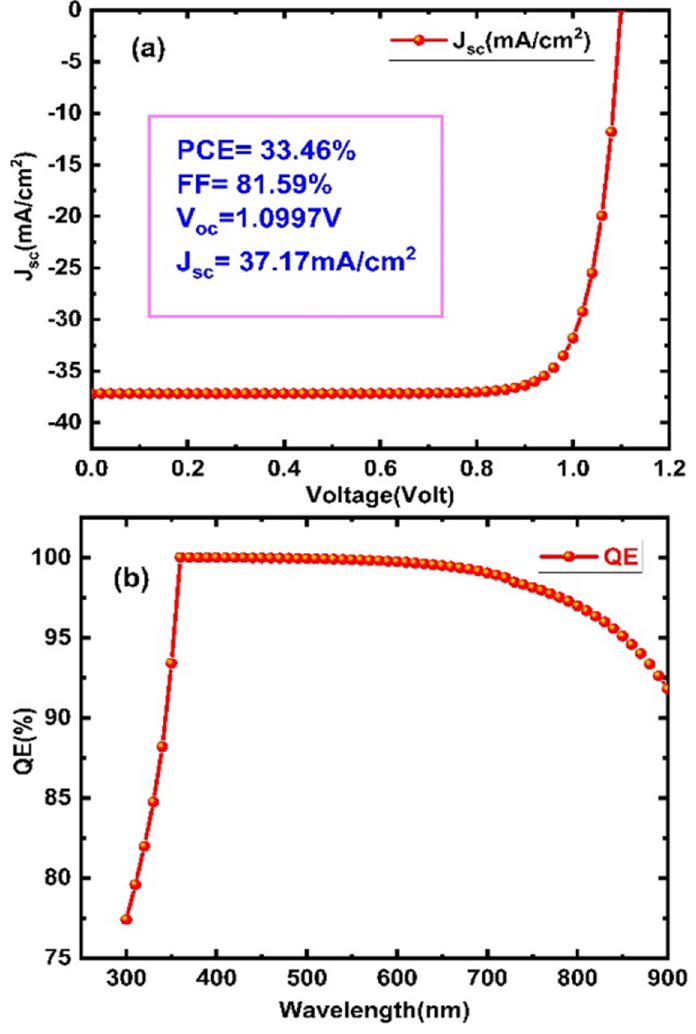
Figure 7. ( a ) Current vs. voltage characteristics and ( b ) QE vs. wavelength of the proposed CH 3 NH 3 SnI 3 based perovskites solar cell.